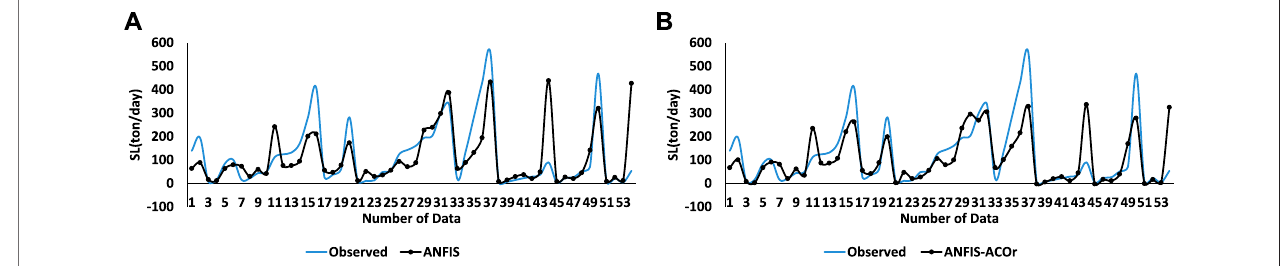
FIGURE 4 | Prediction results by ANFIS and ANFIS – ACOr in single input of CM. (A) Comparing the SL observed with the SL predicted in the ANFIS in test mode, (B) Comparing the SL observed with the SL predicted in the ACOr – ANFIS in test mode.